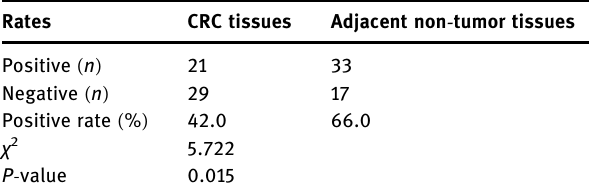
Table 3: Association between DNM3 expression and clinicopatho